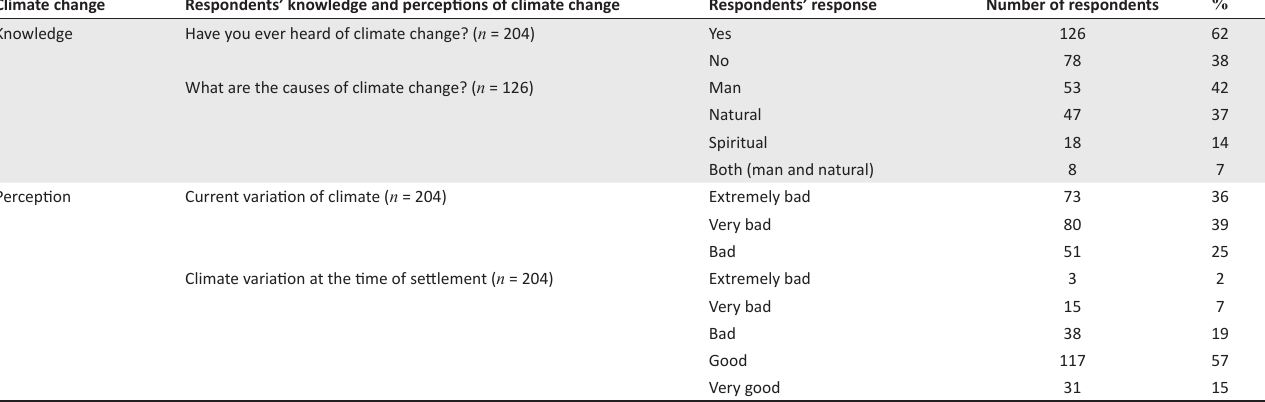
TABLE 2: Respondents’ knowledge and perceptions of the current climate status as well as the climate change at the time of their settlement in Mount Darwin. Climate